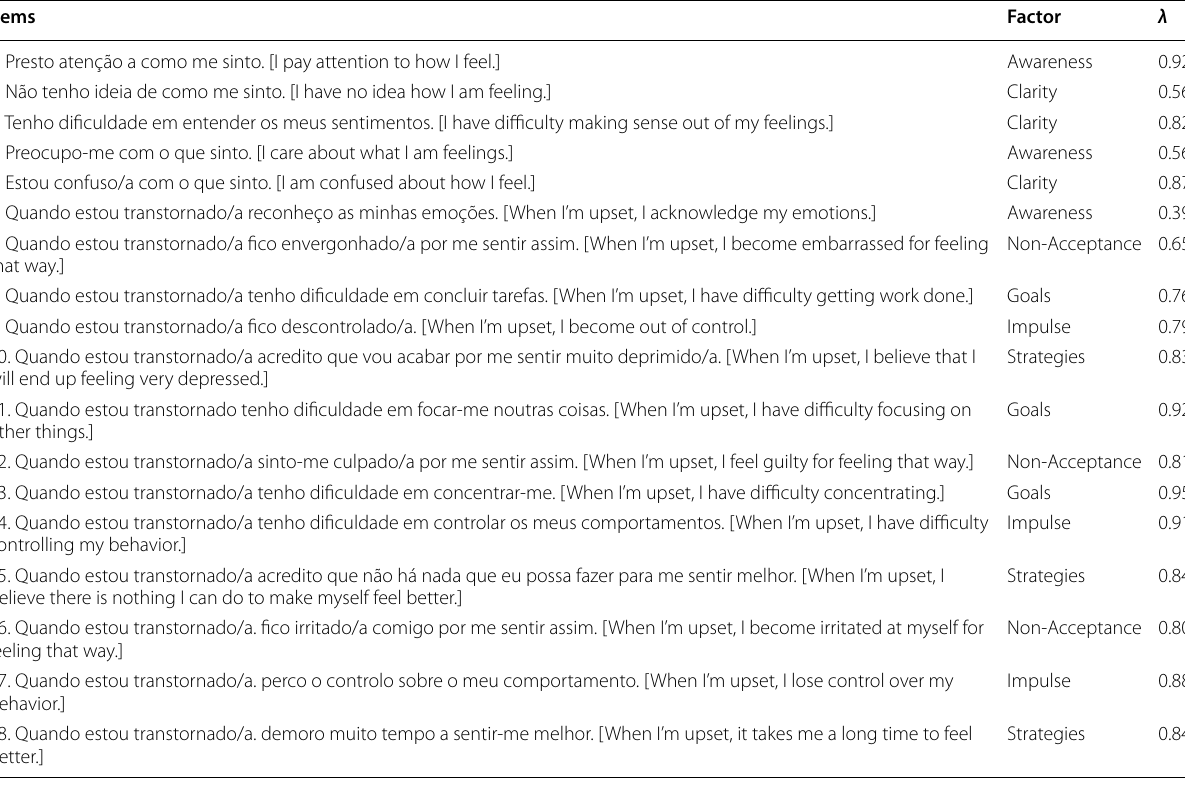
Table 4 Factor loadings of correlated six-factor structure Items Factor